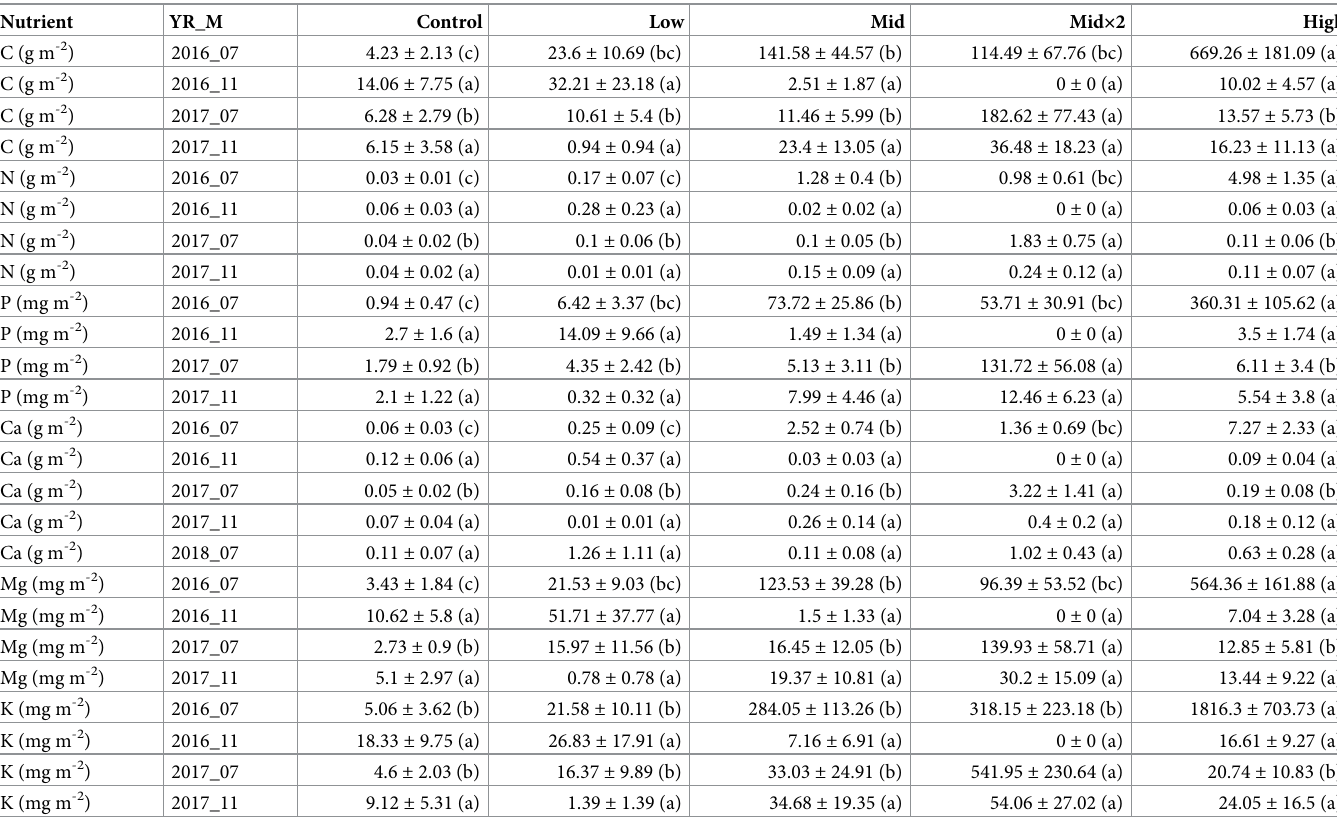
Table 5. Mass of coarse woody debris nutrient elements during each sampling